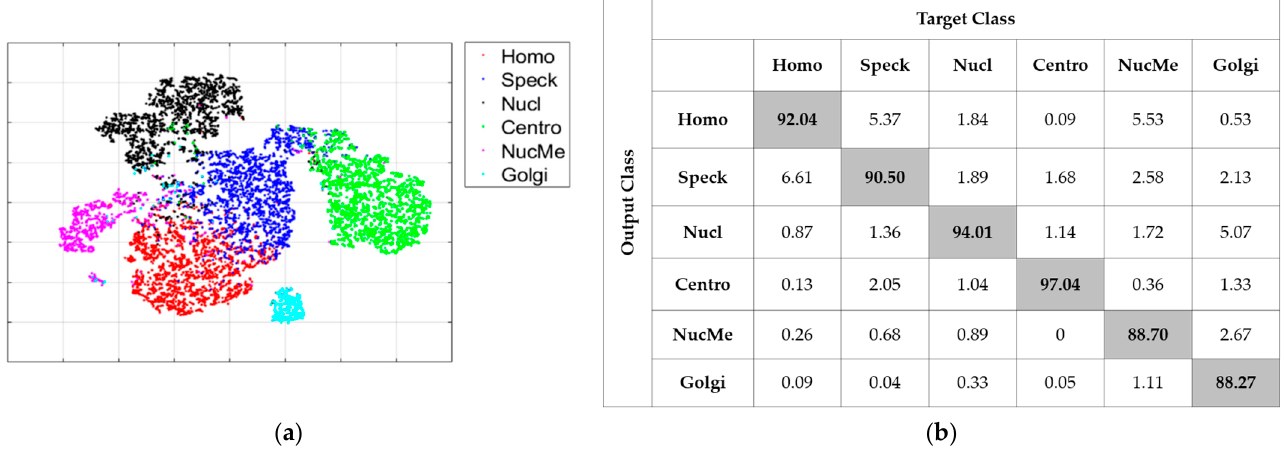
Figure 14. Classification results of the “IN-AL” case: ( a ) features’ visualization and ( b ) confusion matrix.